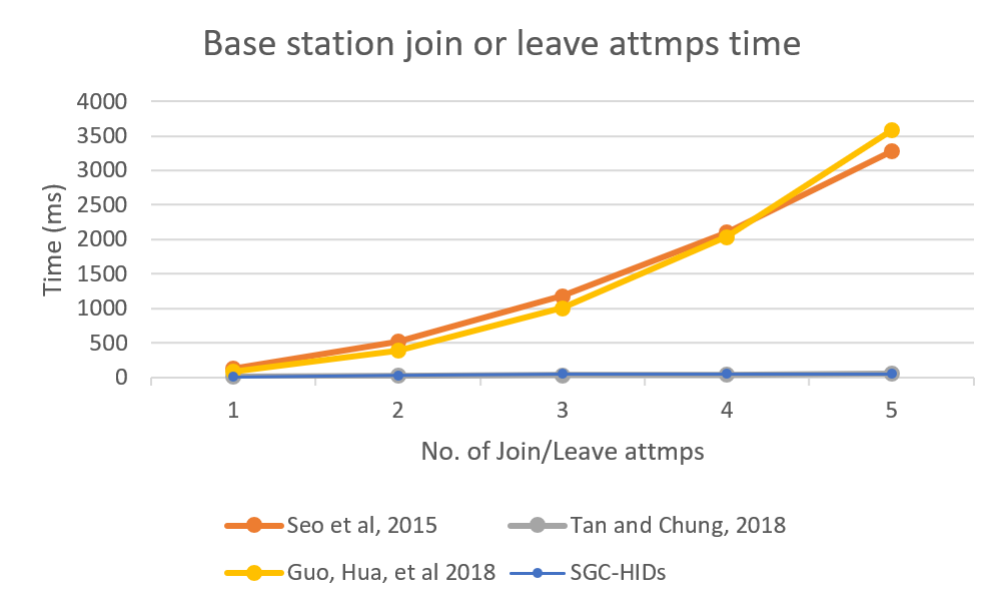
Figure 13. Base station computation time needed for each node joining or leaving the group.